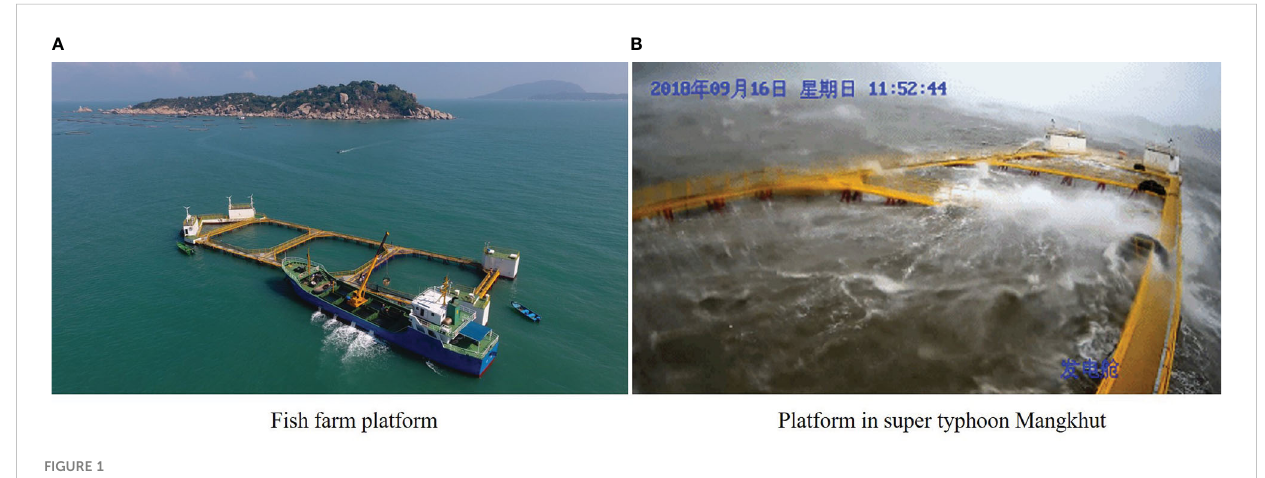
FIGURE 1 DEHAI series DEHAI 1 fi sh farm